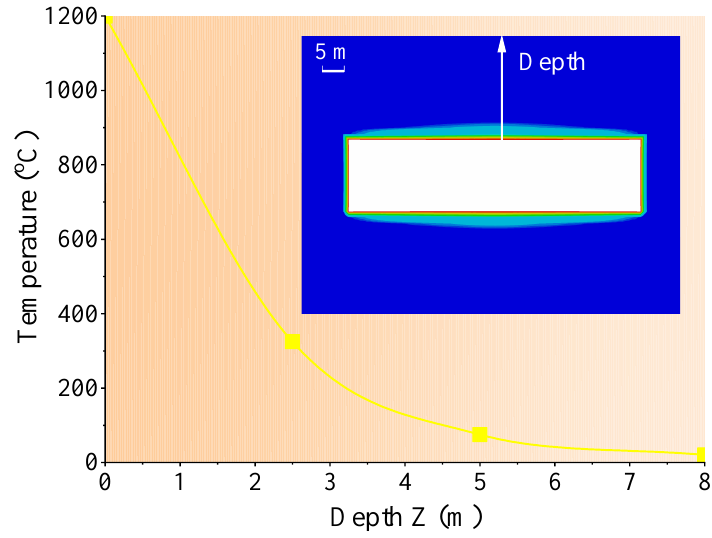
Figure 5. Distribution of temperature in confining